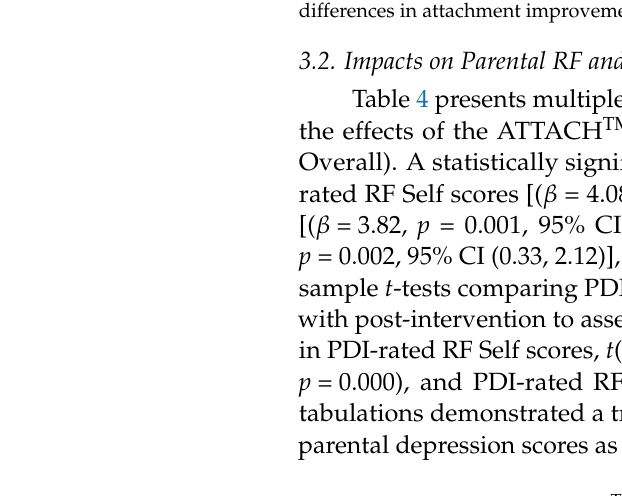
Table 4. Effects of the ATTACH TM intervention on parental reflective